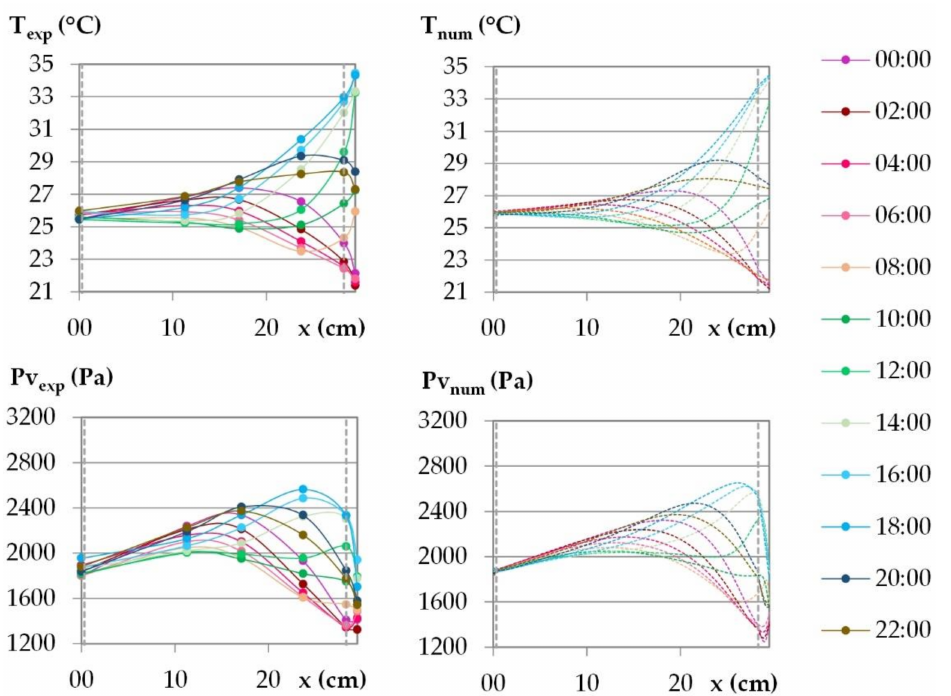
Figure 17. Temperature and vapor pressure profiles during the last day of the dynamic solicitation phase for the climate of Kairouan. Points: experimental values; dotted lines: numerical values.